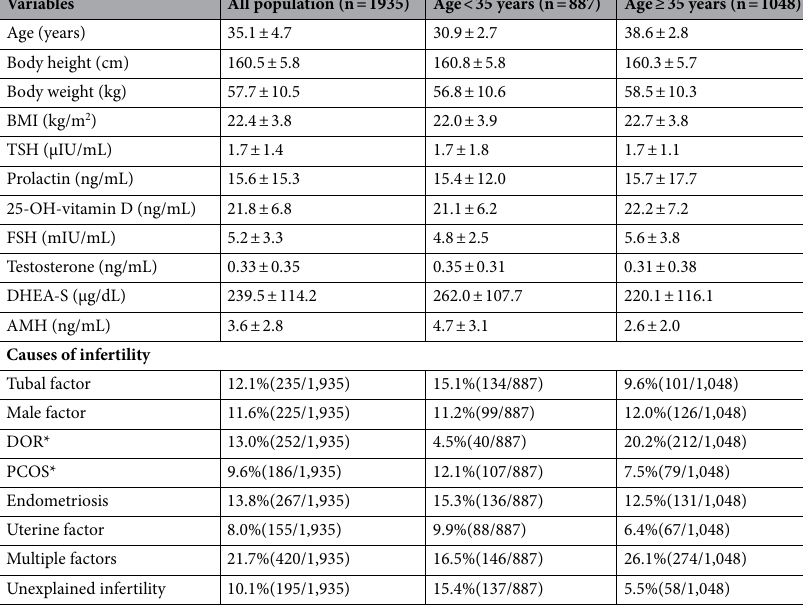
Table 1. The characteristics of the study population. Data are presented as the mean ± standard deviation. BMI body mass index, TSH thyroid-stimulating hormone, FSH follicle stimulation hormone, DHEA-S dehydroepiandrosterone sulfate, AMH anti-Müllerian hormone. *DOR, diminished ovarian reserve, was defined as AMH < 1.2 ng/mL based on POSEIDON criteria. *PCOS, polycystic ovarian syndrome, was determined by Rotterdam